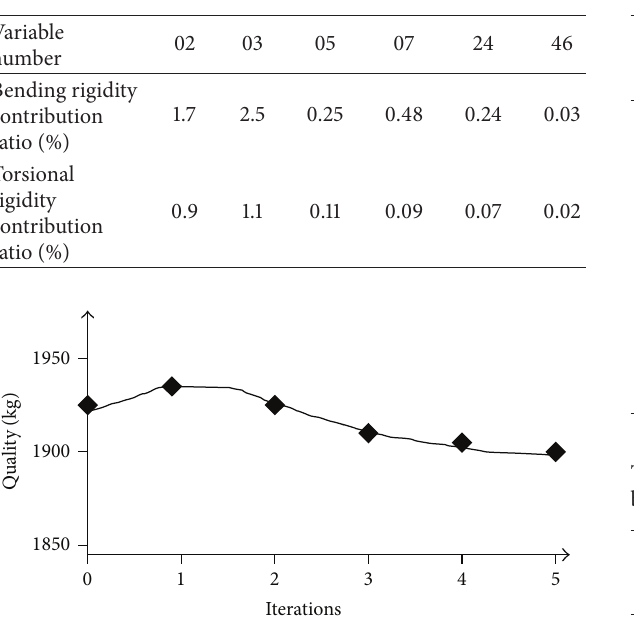
Table 5: The bending sensitivity of main parts weight and thickness.